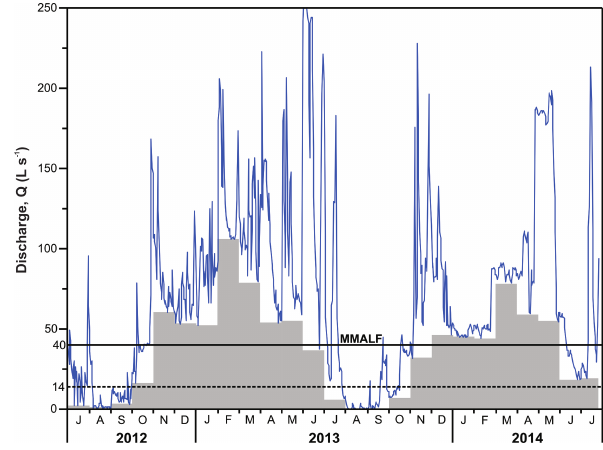
Figure 10. Hydrograph of Dluga Woda stream. Grey histogram re- flects monthly low flows for the period July 2012–June 2014. The mean monthly annually low flow (MMALF) equal to 40Ls − 1 cor- responds to the baseflow of the stream. The characteristic discharge rate of 14Ls − 1 (see Fig. 11) is marked by dashed line (see